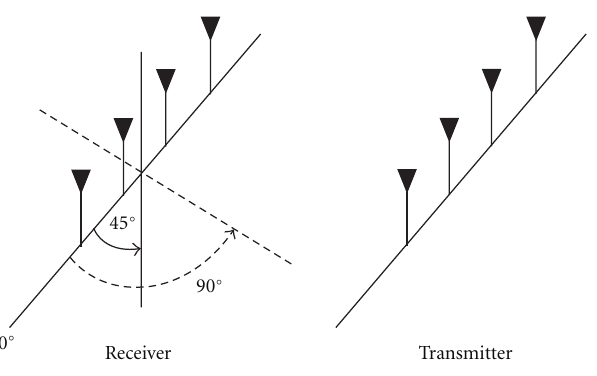
Figure 11: The rotating directions of array antennas for measure- ment scenarios.